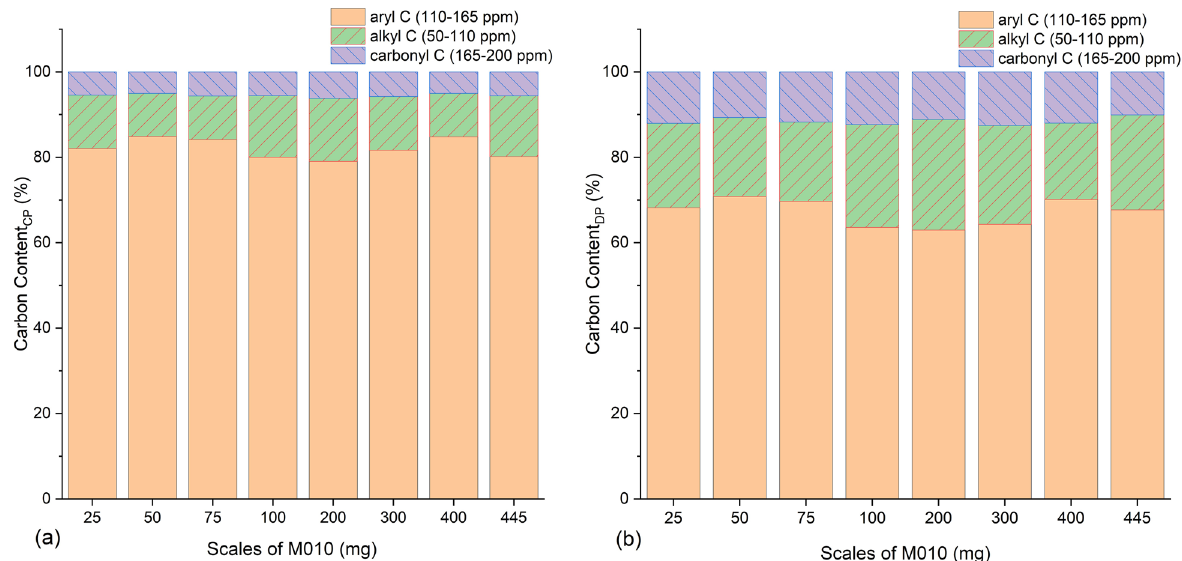
Fig. 5 The biochar produced from different mass scales of pyrolysis of M010 in TGA showing the distribution of carbon content (%) in biochar as a percentage of. 13 C NMR ( a ) cross polarization (CP) signal intensity and ( b ) direct polarization (DP)